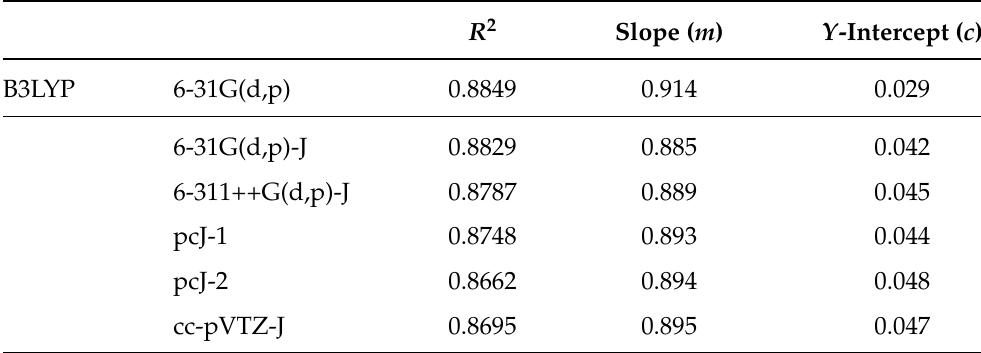
Table 3. Calculated R 2 , slope, and intercept values with reference to B3LYP/6-31G(d,p) values. All results were generated using the PCM solvation model.